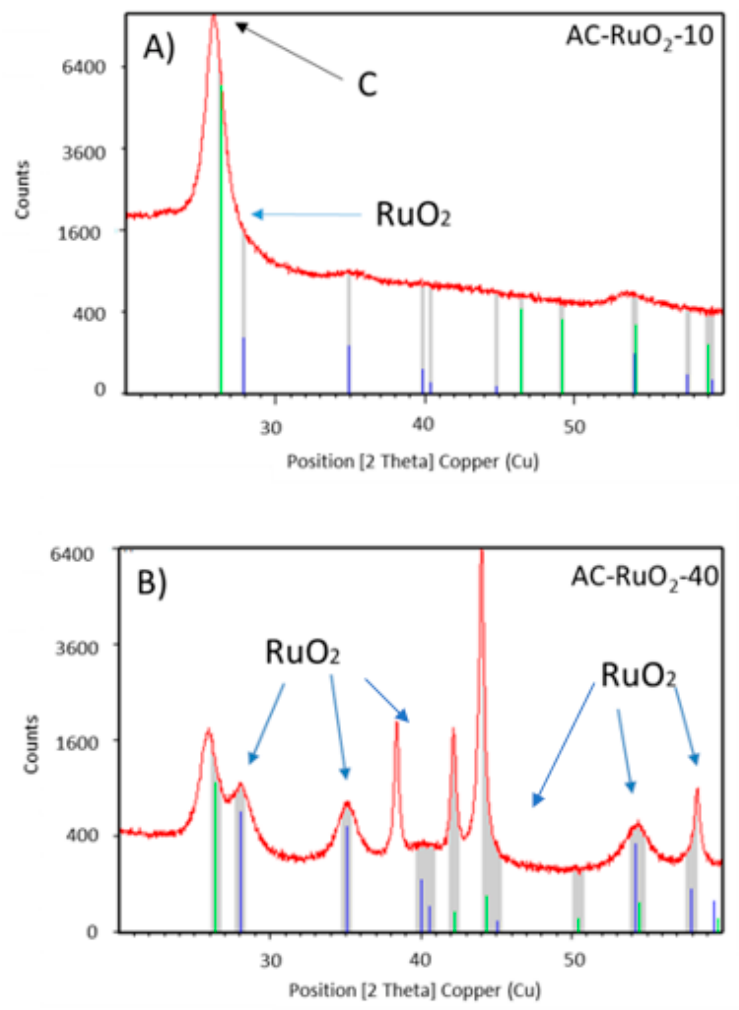
Figure 6. X-ray diffraction patterns of ( A ) AC-RuO 2 -10 and ( B ) AC-RuO 2